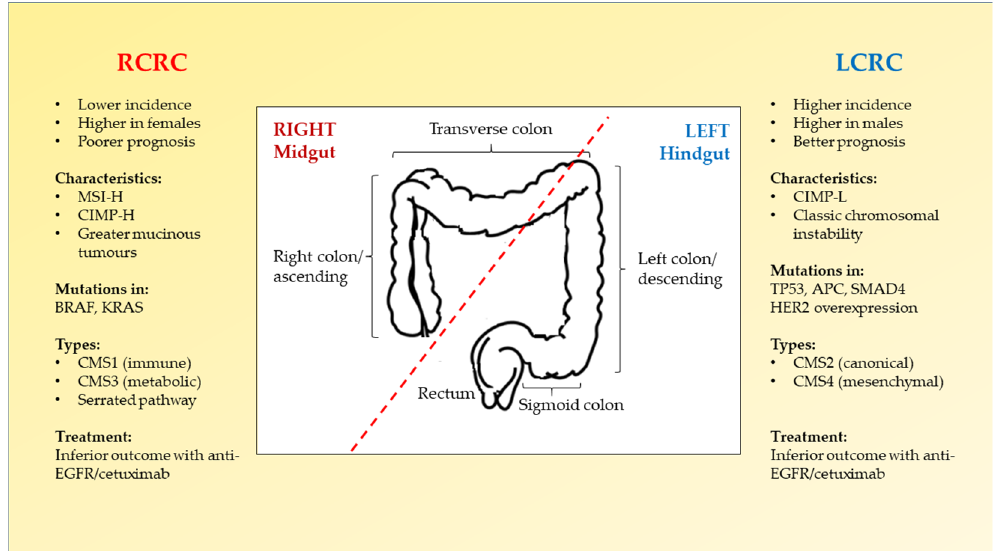
Figure 1. Right-sided CRC (RCRC) versus left-sided CRC (LCRC). RCRC and LCRC can be differentiated according to the anatomy (indicated by the red dotted line), their prevalence, prognostic value and molecular signatures. These factors determine the most suitable treatment for CRC patients to improve their survival.